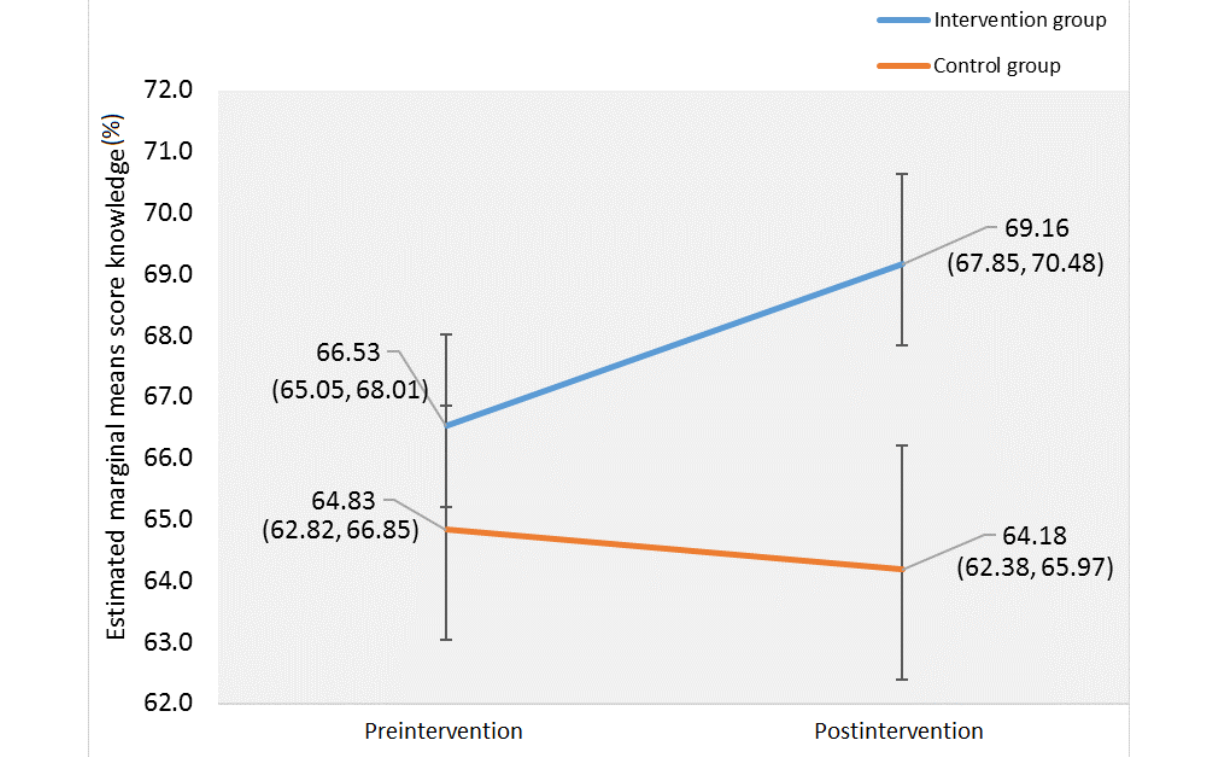
Figure 1. Profile plot of the estimated marginal means of the mean percentage scores for knowledge between pre- and postusage of